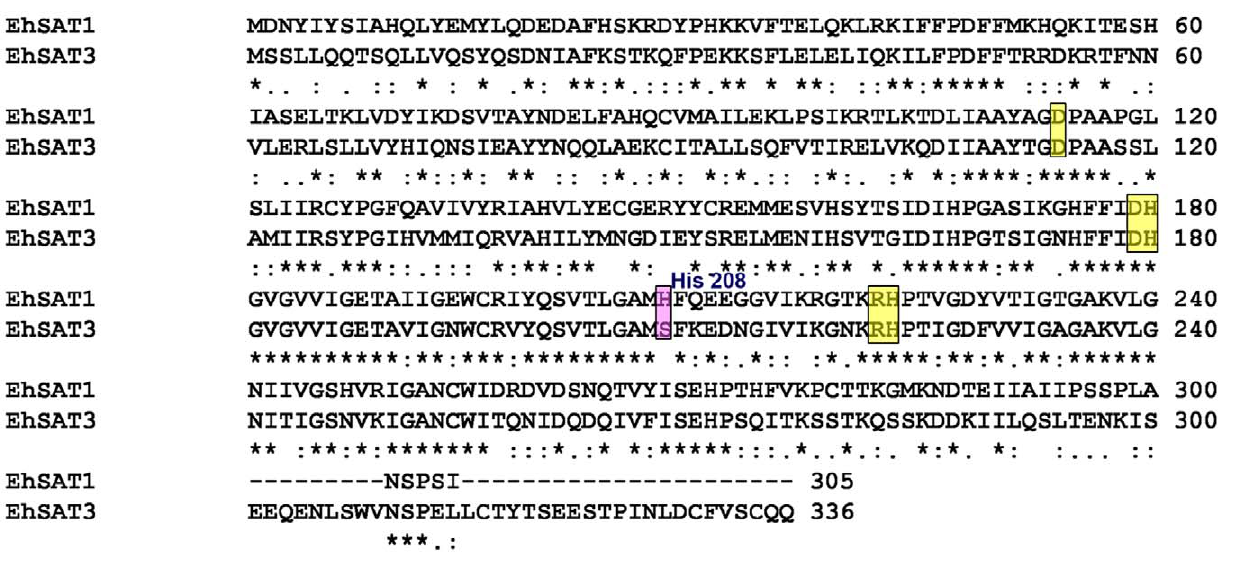
Figure 1. Protein sequence alignment of EhSAT1 and EhSAT3. Protein sequence alignment was done using ClustalW alignment program. Conserved active site residues are highlighted in yellow boxes while the active site residues (at position 208) that differ in the isoforms are highlighted in a pink box.